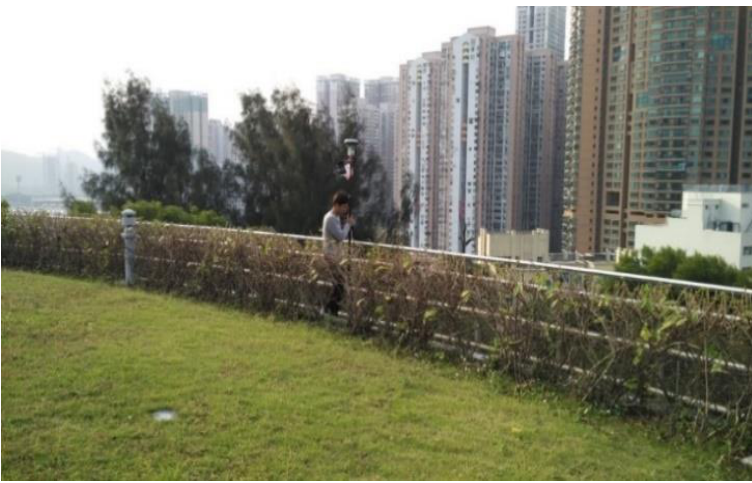
Figure 4. Experiment on an observation deck in Macau, China.